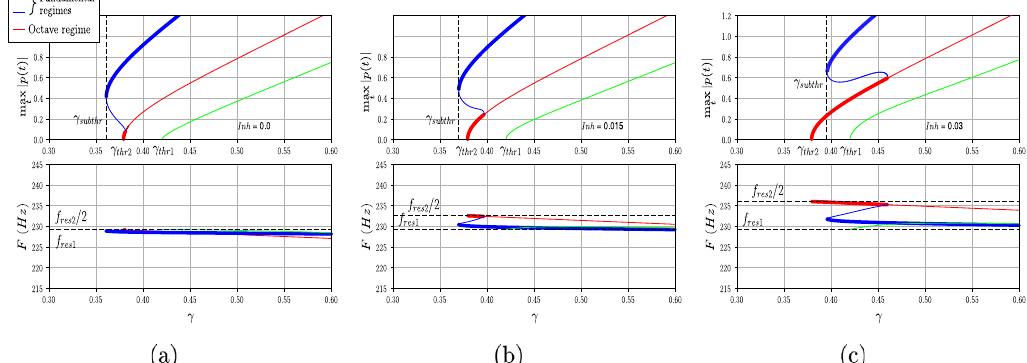
Figure 7. Three bifurcation diagrams of the two quasi-harmonic resonance air column (with Z 1 < Z 2 , in practice Z 2 / Z 1 = 3/2) with respect to the control parameter c . From top to bottom: Inh = 0 (a), Inh = 0.015 (b) and Inh = 0.030 (c). Each case is described with two plots. Upper plot (a): Maximum of the absolute value of the periodic solution with respect to c . The branch in red (respectively in blue, and in green) corresponds to the octave regime (respectively the fundamental regime associated to the standard Helmholtz motion, and the inverted Helmholtz motion fundamental regime). Lower plot (c): Frequency with respect to c . The frequency branch in red (respectively in blue) corresponds to the fundamental frequency of the octave regime (respectively the fundamental regime). The frequency of the red branch has been divided by 2 for sake of clarity. The reference dashed horizontal lines are the reference frequencies: f res1 and f res2